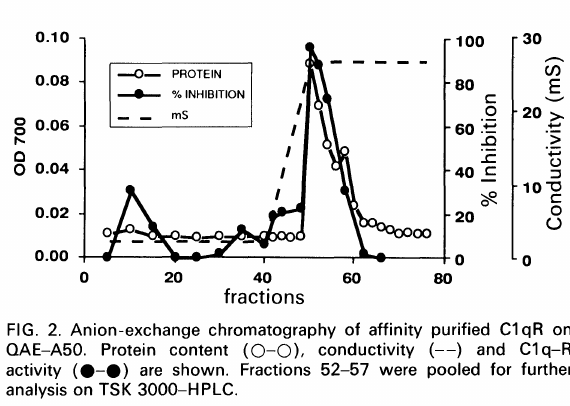
FIG. 2. Anion-exchange chromatography of affinity purified ClqR on QAE-A50. Protein content (O-C)), conductivity (--) and Clq-R activity (O-I) are shown. Fractions 52-57 were pooled for further analysis on TSK 3000-HPLC. Mediators of Inflammation. Vol 2- 1993